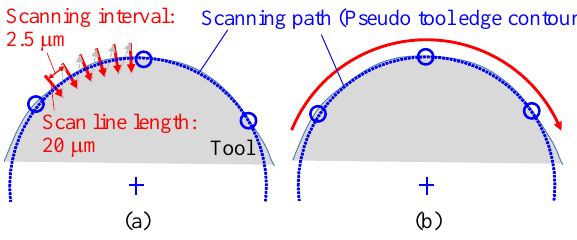
Figure 10. Schematics of the scanning paths for round cutting edge measurement. (a) Raster-scan method. (b) Direct-scan method.